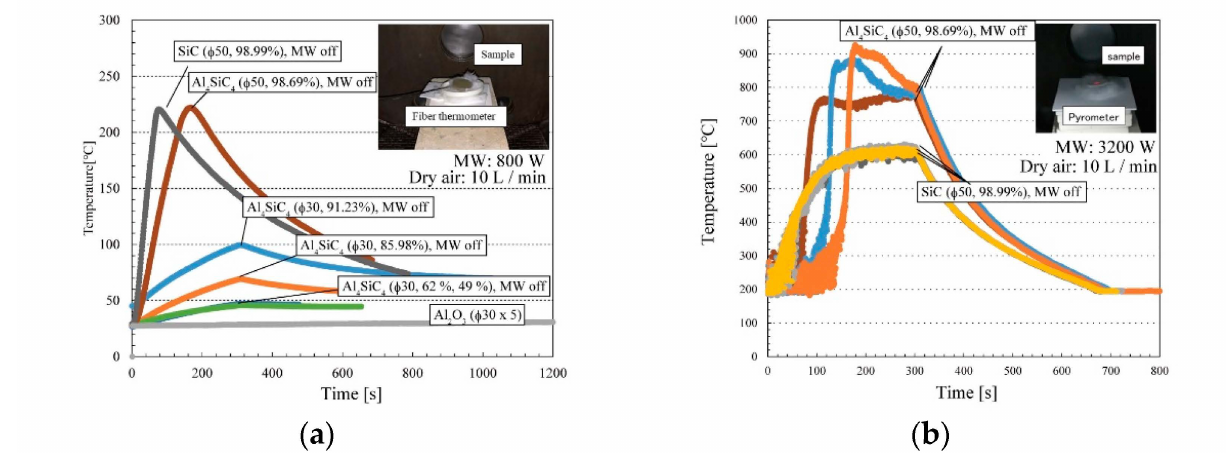
Figure 5. ( a ) Time vs. temperature plots of sintered Al 4 SiC 4 samples ( ∅ 50 mm × 5 mm, ∅ 30 mm × 5 mm) irradiated with microwaves at 800 W and ( b ) 3.2 kW. Preliminary tests confirmed that the alumina and refractory bricks used for the table were not heated by the